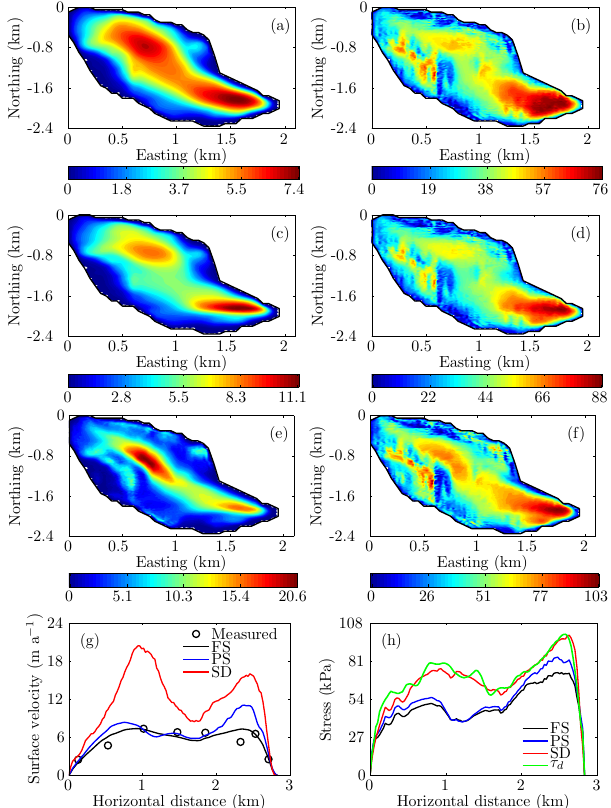
Fig. 6. Present-day surface velocity (m a − 1 ; left panel) and basal shear stress (kPa; right), obtained from diagnostic simulations of (a–b) FS, (c–d) PS, and (e–f) SD models. Notice that, for better readability, we use different color scales for each model output. Modeled (g) surface velocity and (h) basal shear stress along the central flowline. Measured velocity (in g ) and the analytical solu- tion to driving stress (in h ) are also